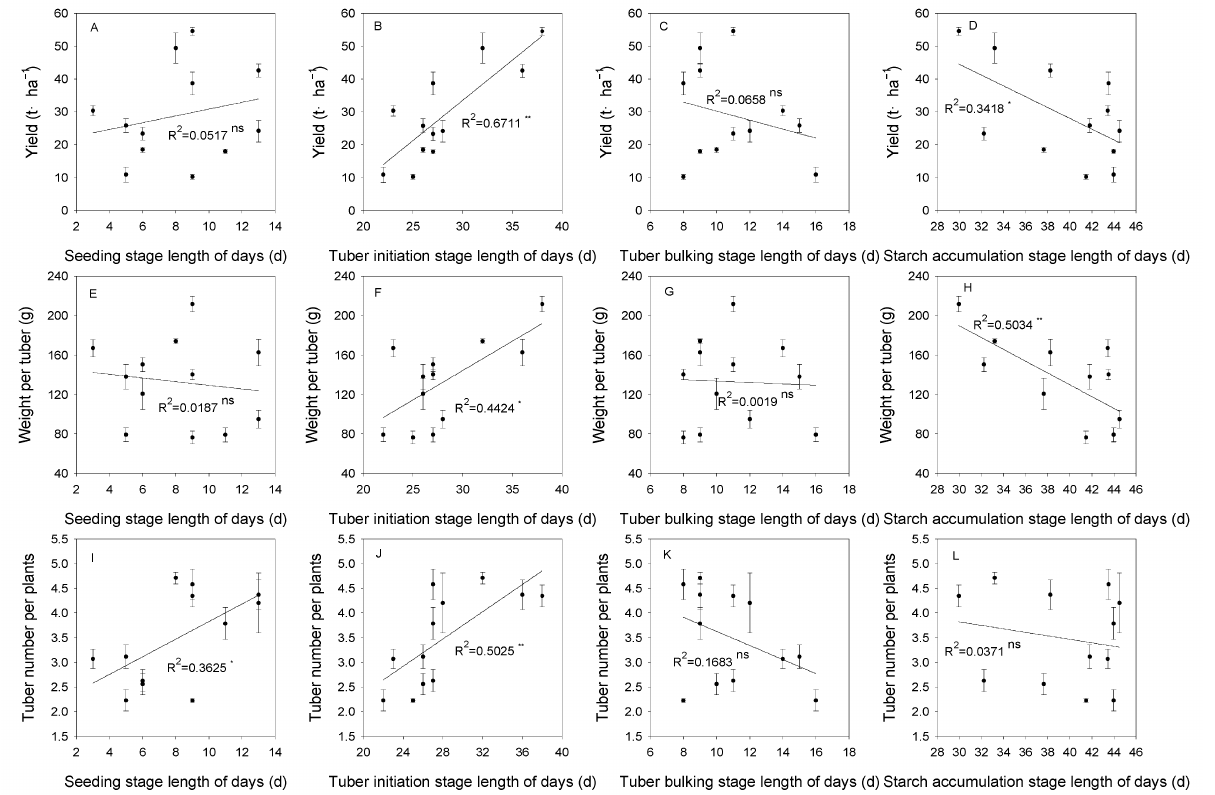
Figure 5. Correlation of growth stage length of days to yield and its components. The figures show the correlations between seedling stage, tuber formation stage, tuber expansion stage and starch accumulation stage and yield ( A – D ), weight per potato ( E – H ) and number of potatoes ( I – L ). The error bar is the standard error; the line is the result of a linear fitting; R 2 is the coefficient of determination; “ns” means no significant, “*” means significant difference at 0.05 level, and “**” means significant difference at 0.01